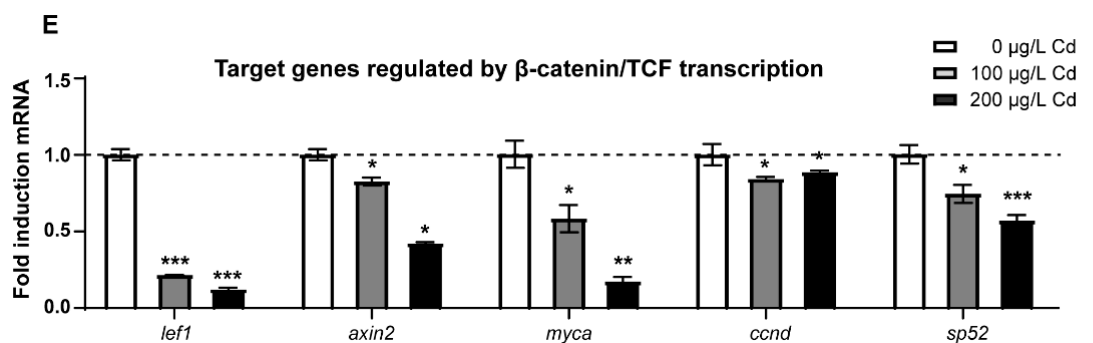
Figure 1. Cd 2+ exposure inhibited zebrafish Wnt/ β -catenin signaling pathway. ( A , B ) Western blot analysis and quantitation of β -catenin expression levels in 6 dpf zebrafish larvae exposed to different levels of Cd 2+ . ( C – E ) qRT-PCR analysis of relative expression of genes involved in Wnt/ β -catenin signaling pathway. The values are presented as the mean ± SEM. The results of either nonparametric test or ANOVA followed by multiple comparison test are listed in Table S2. “*” indicates significant differences (* p < 0.05, ** p < 0.01, *** p < 0.001).